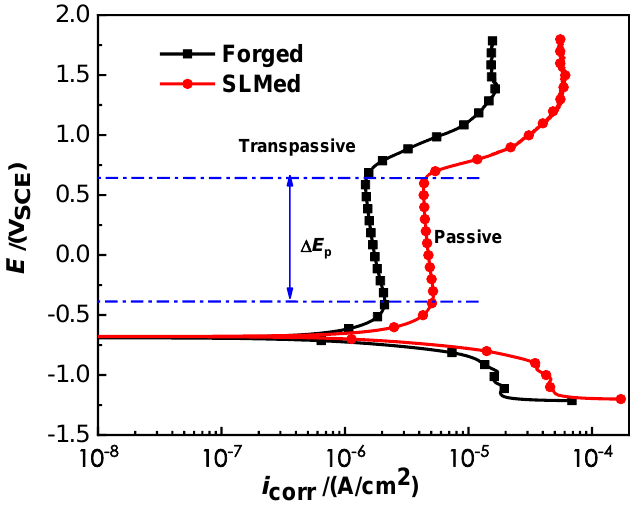
Figure 7. Polarization curves of the two tested Ti-6Al-4V alloys in 0.1 mol/L NaOH solution. Table 3. Tafel fitting results derived from the polarization curves. E corr (V SCE